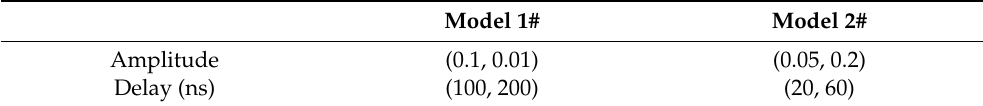
Table 2. Two multipath